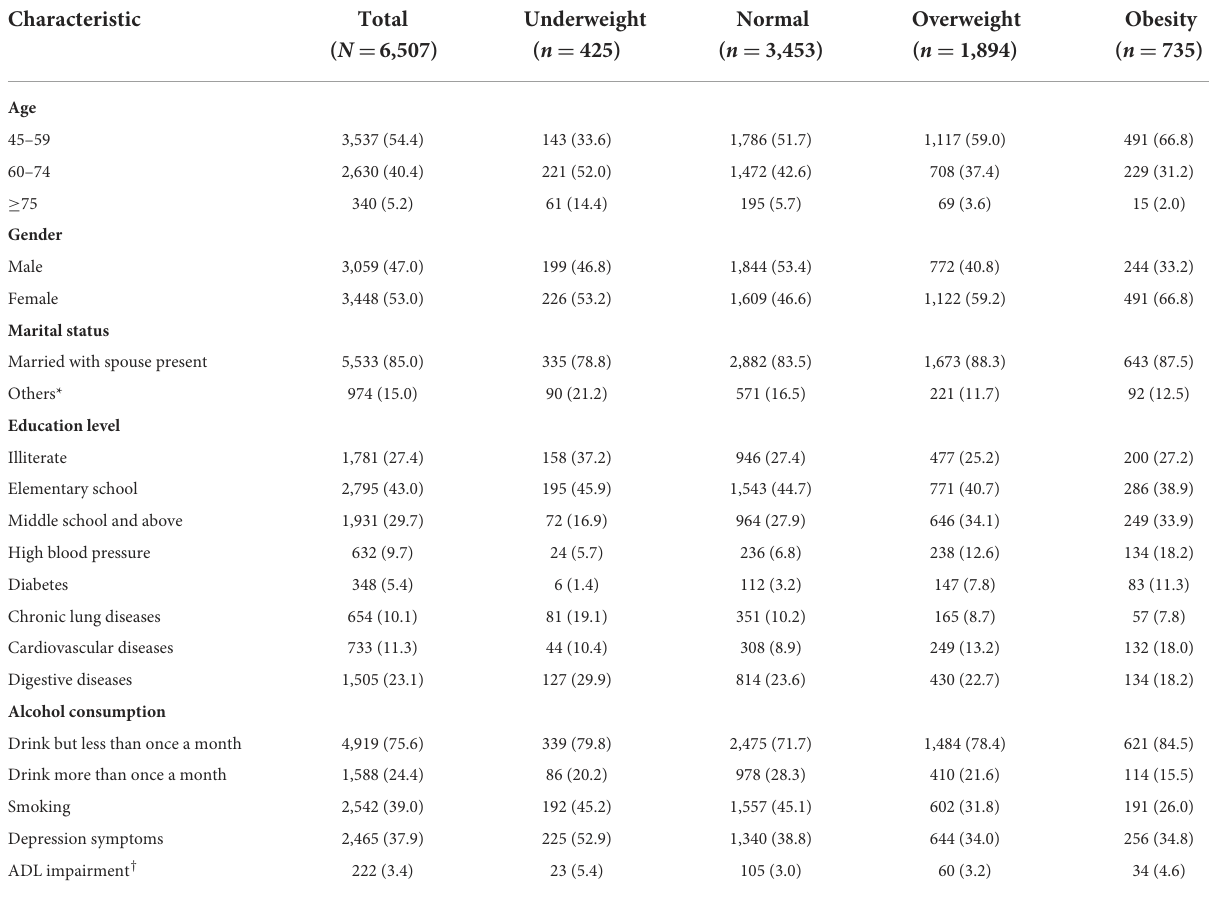
TABLE 1 Baseline characteristics of the participants under study.